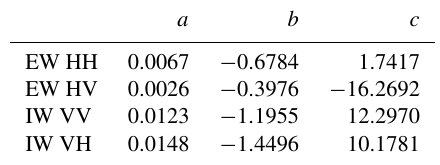
Table 3. Polynomial coefficients used for the incidence angle nor- malisation with respect to the sensor mode and